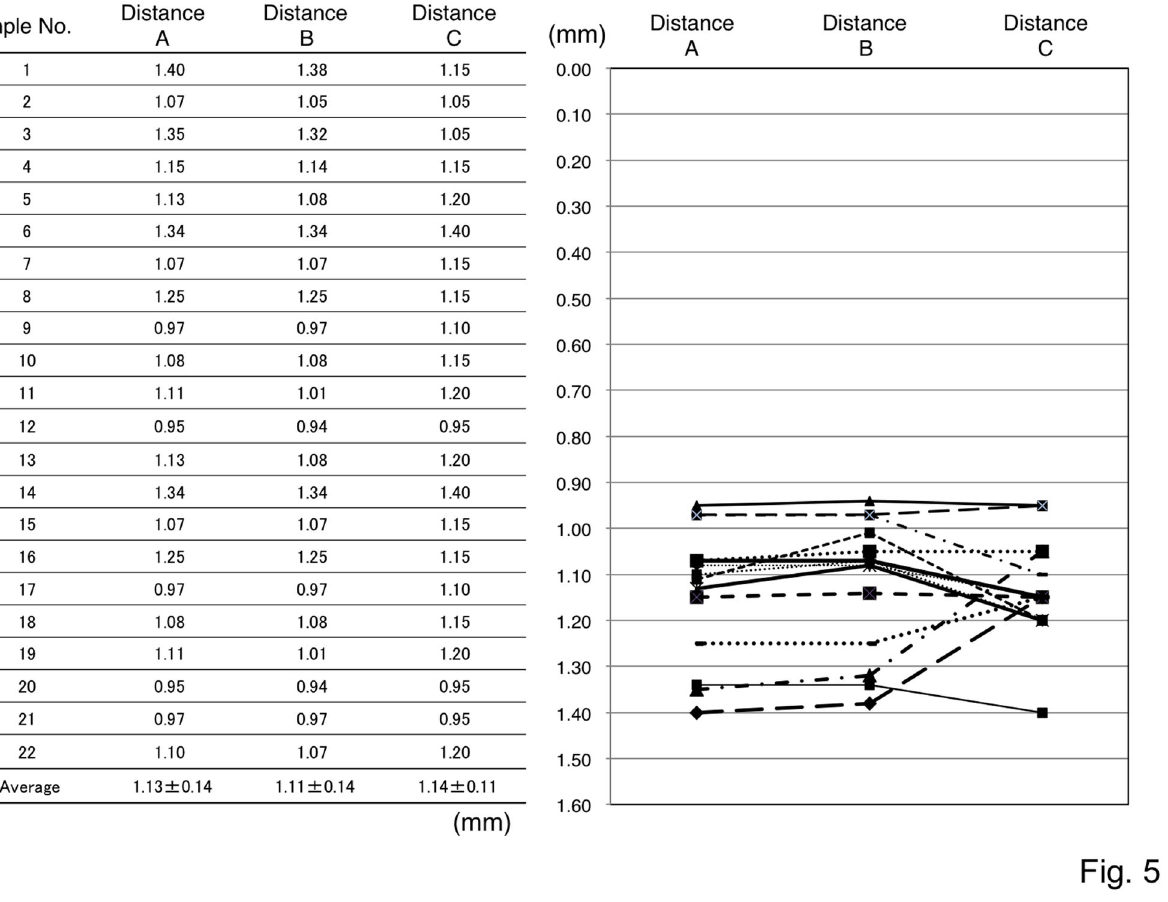
Figure 5. Comparison of distance from the cortical surface to the CA1 pyramidal layer in histological analyses and practical